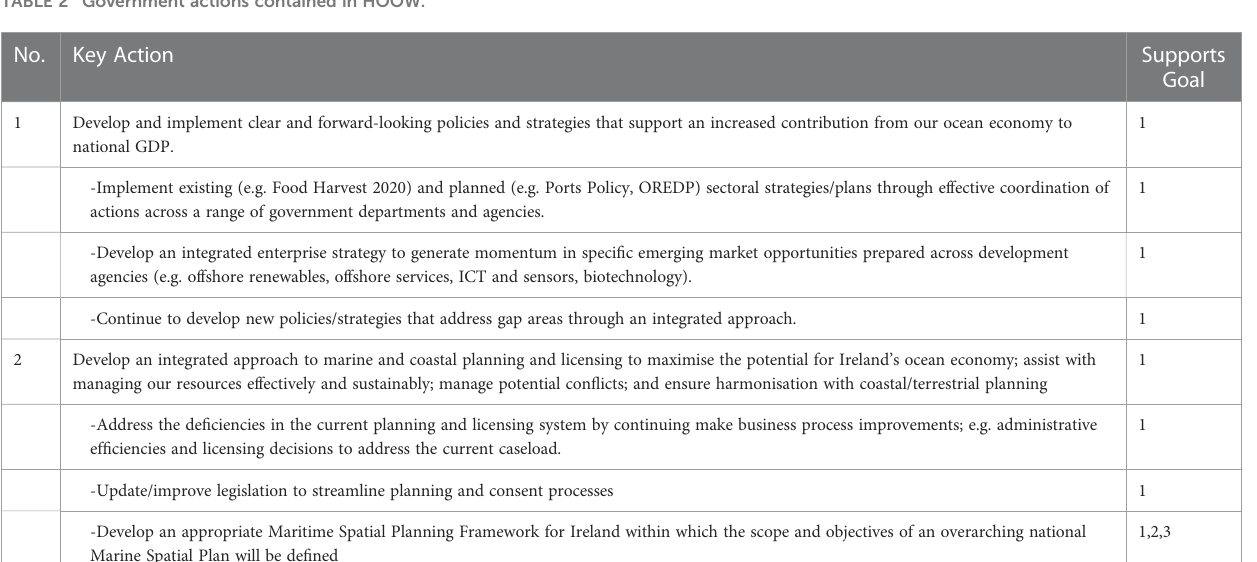
TABLE 2 Government actions contained in